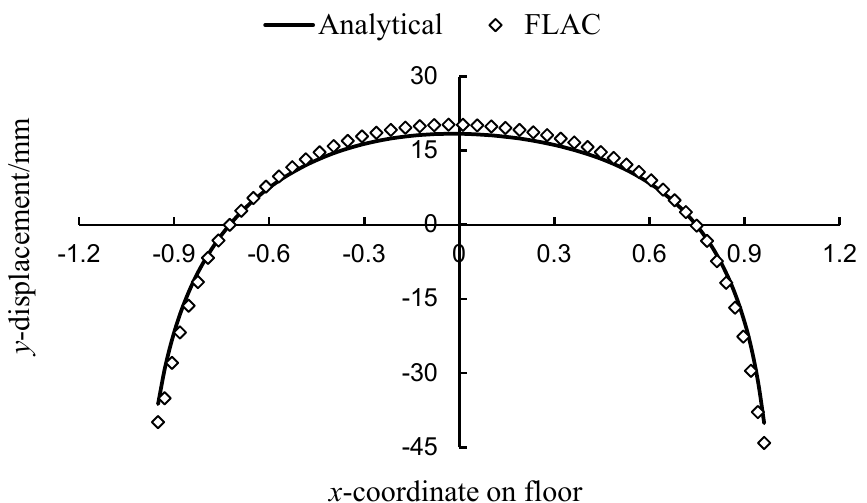
Figure 5. The y -displacement on floor for right-angle trapezoidal opening.